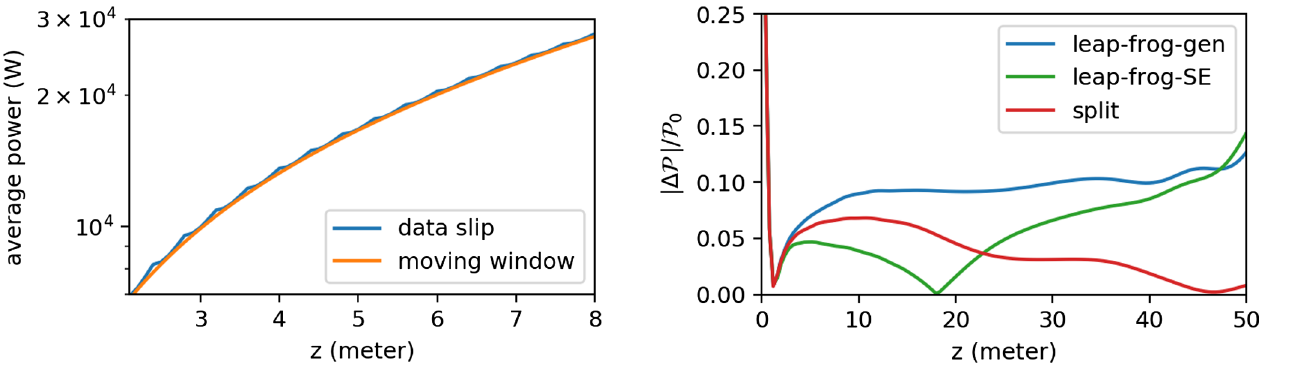
FIG. 8. Effect of slippage resolution on power gain curve. Same parameters are used as Fig. 5. The integration step size is 5 wiggler period and the temporal mesh size is 20 wavelength. The blue line is CD and the orange line is the MW.